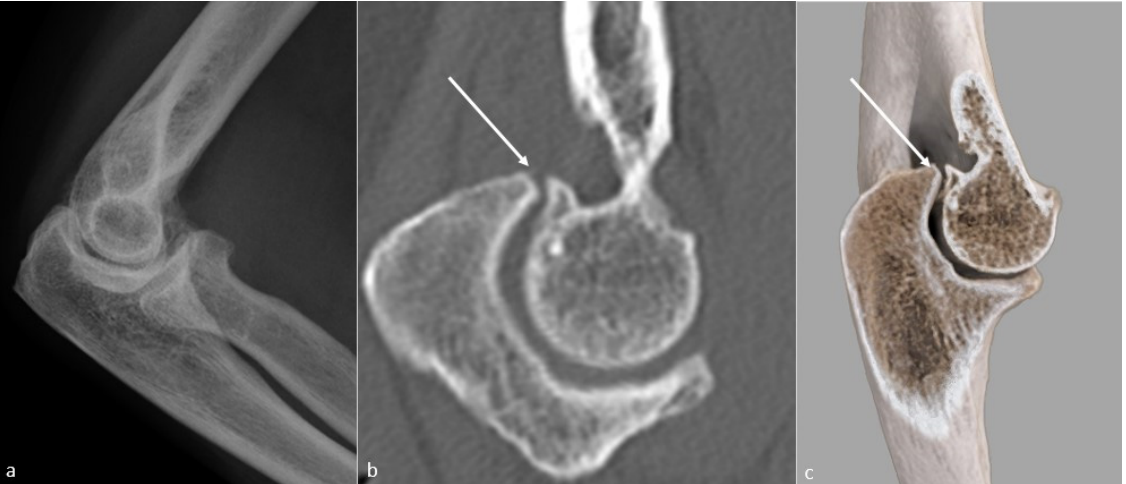
Figure 5. Loss of extension secondary to a bony osteophytic impingement. A bone block secondary to a trochlear osteophyte (white arrow) in a 51-year-old man, manual worker, is shown on ( a ) a profile view radiograph (not depicted), ( b ) a sagittal CT-scan reformat, and ( c ) a global illumination 3D reformat.